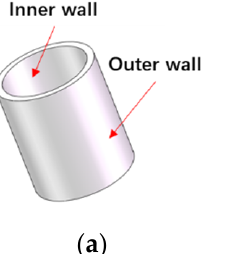
Figure 1. ( a ) Sensitive structure of vector channel. ( b ) Schematic diagram of stress on beam. ( c ) Ge- ometric parameter schematic of vector channel.